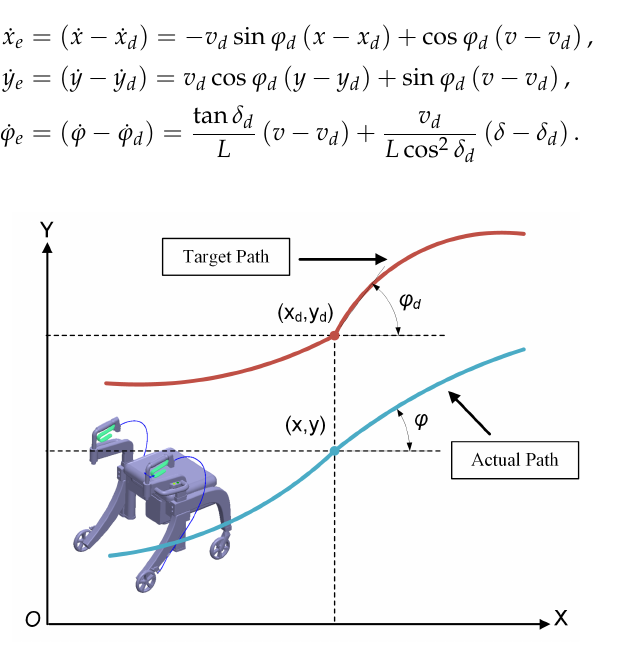
Figure 10. Trajectory tracking